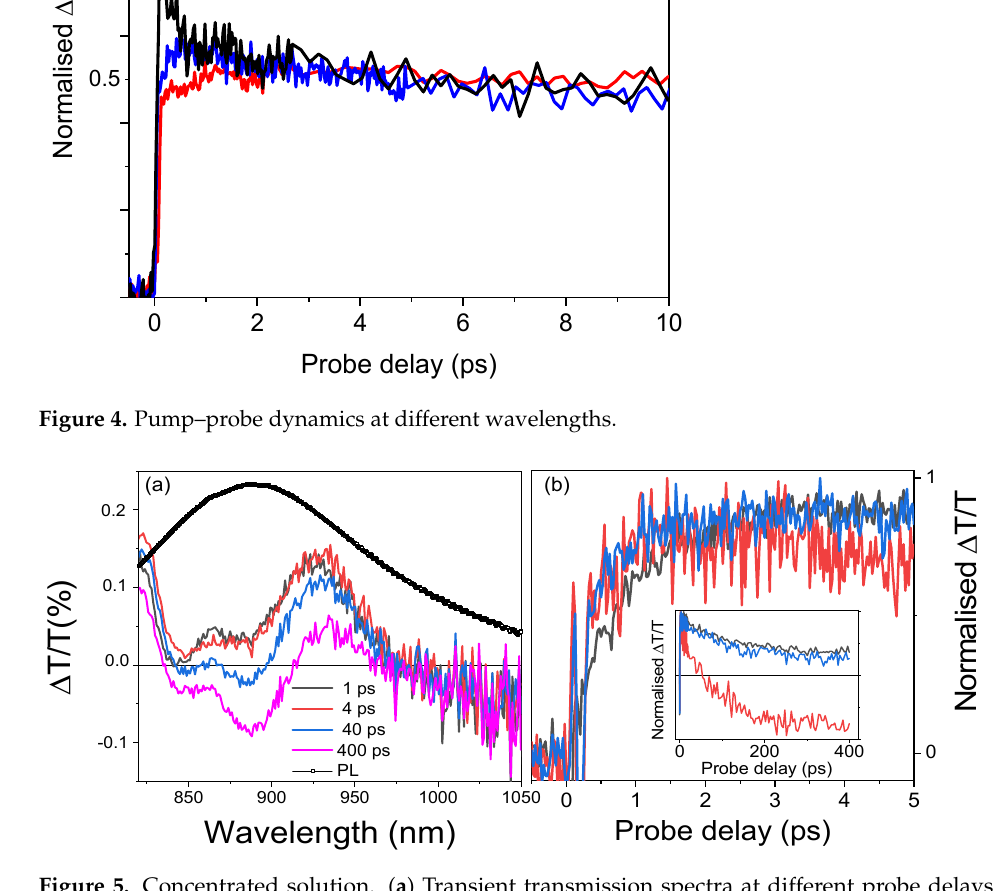
Figure 5. Concentrated solution. ( a ) Transient transmission spectra at different probe delays in the NIR spectral region. The weak PL band is also shown for clarity (grey line with open circles). ( b ) Dynamics at different probe wavelengths: 825 nm (black line), 900 nm (red line), and 930 nm (blue line). In the inset, the same dynamics over a 400 ps temporal window are shown.